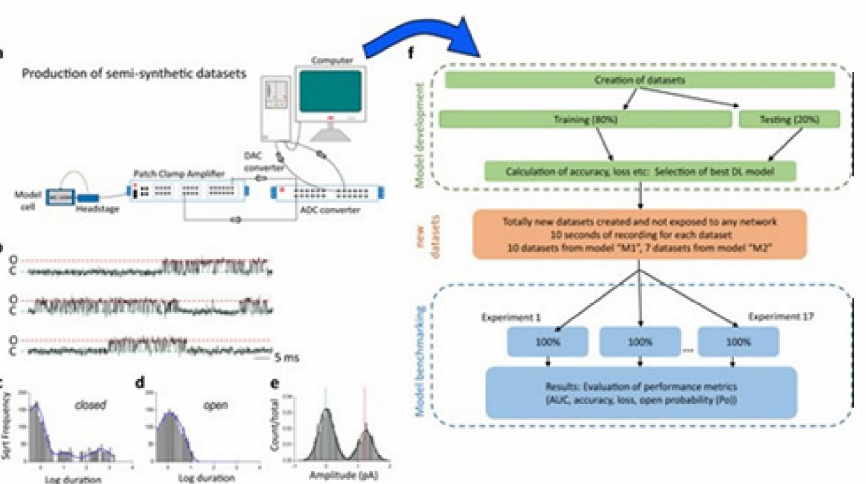
Figure 10. The workflow-diagram: the artificial analogue datasets generation. ( a ) the training, the validation and the benchmarking, the data got generated first as the fiducial records with having authenticated kinetic-models using MATLAB (Figure 11); the data have then been played out via a CED digital-to-analogue converter to the amplifier of a patch clamp sending the signal into a (model) cell, and then recorded the signal back (simultaneously) to a hard disk having the CED Signal software through a CED analogue-to-digital converter. The noise degree got altered by moving the headstage of the patch-clamp closer to, or a bit further from PC. Raw patch-clamp data produced in these described methods are found indistinguishable from the genuine patch-clamp data. For illustrating the point, this shows a standard work-up analysis for an experiment having ( b ) raw data, followed by it’s analyses with QuB: kinetic analyses of ( c ) channel-open and ( d ) closed dwell times. They finally show ( e ) all the points amplitude histogram ( f